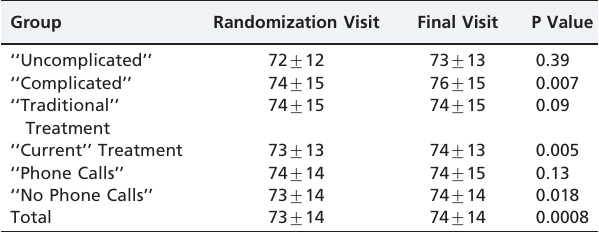
Table 5 - Weight (kg) at the beginning and end of the